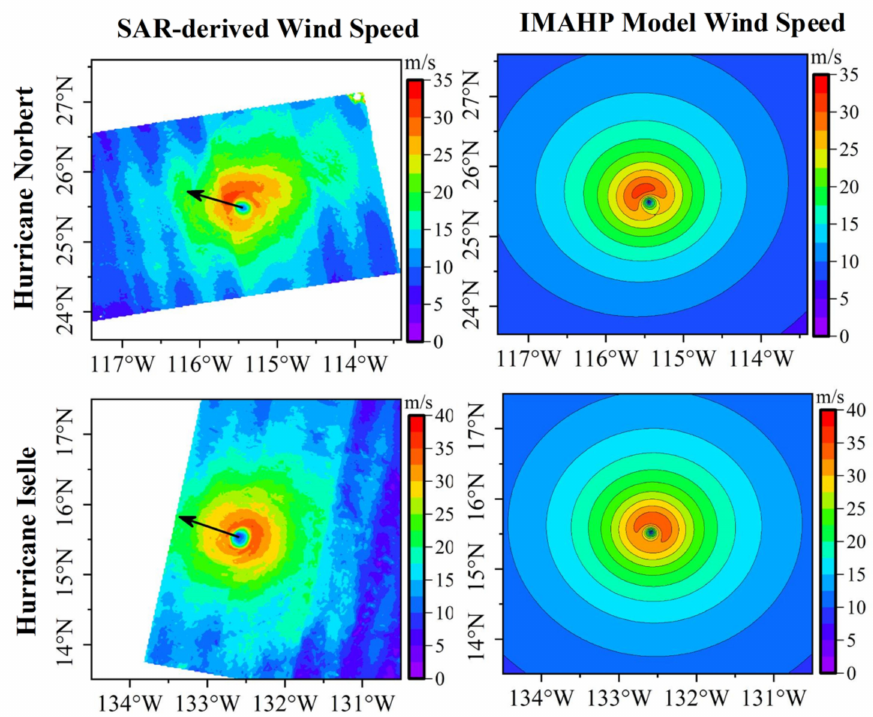
Figure 7. The distribution of 2D wind speed derived by SAR ( left ) and simulated by the IMAHP model ( right ). The black arrows indicate the direction of movement of the hurricanes, which were calculated from the best track